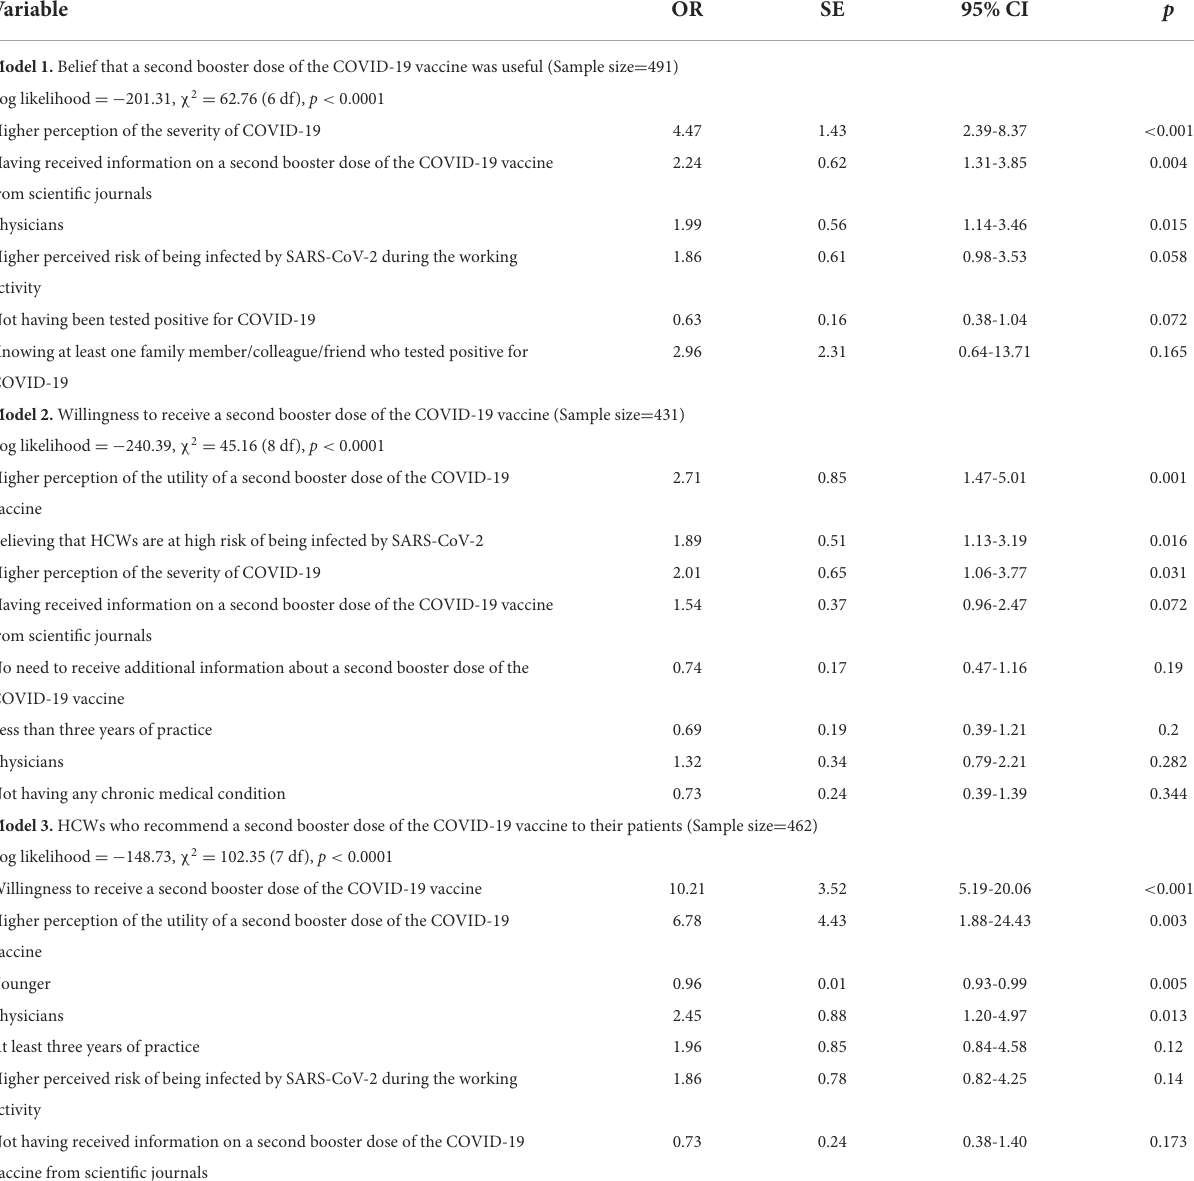
TABLE 2 Results of the multivariate logistic regression analysis showing determinants of the different outcomes of interest. Variable OR SE 95% CI